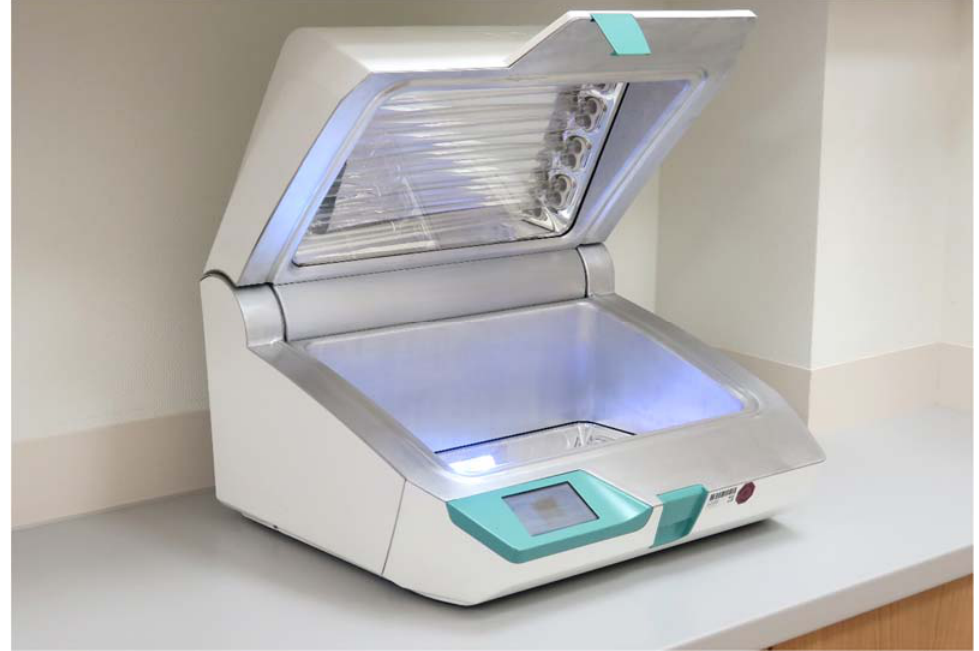
Figure 2. D25 UV light system for endoscope disinfection.